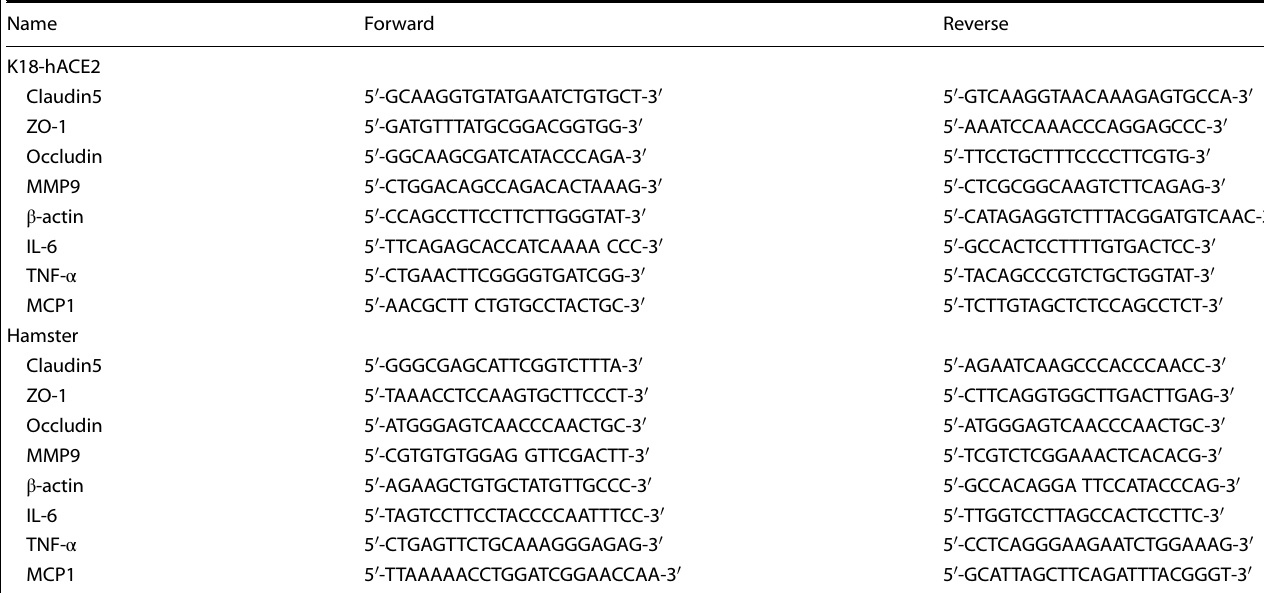
Table 3. The sequence of oligonucleotides used in RT-PCR